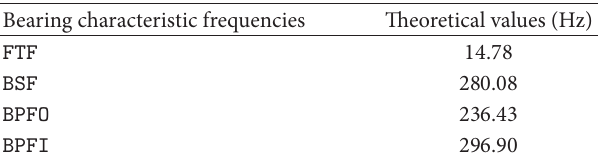
Table 4: Rexnord ZA- 2115 BCFs for running speed 2000